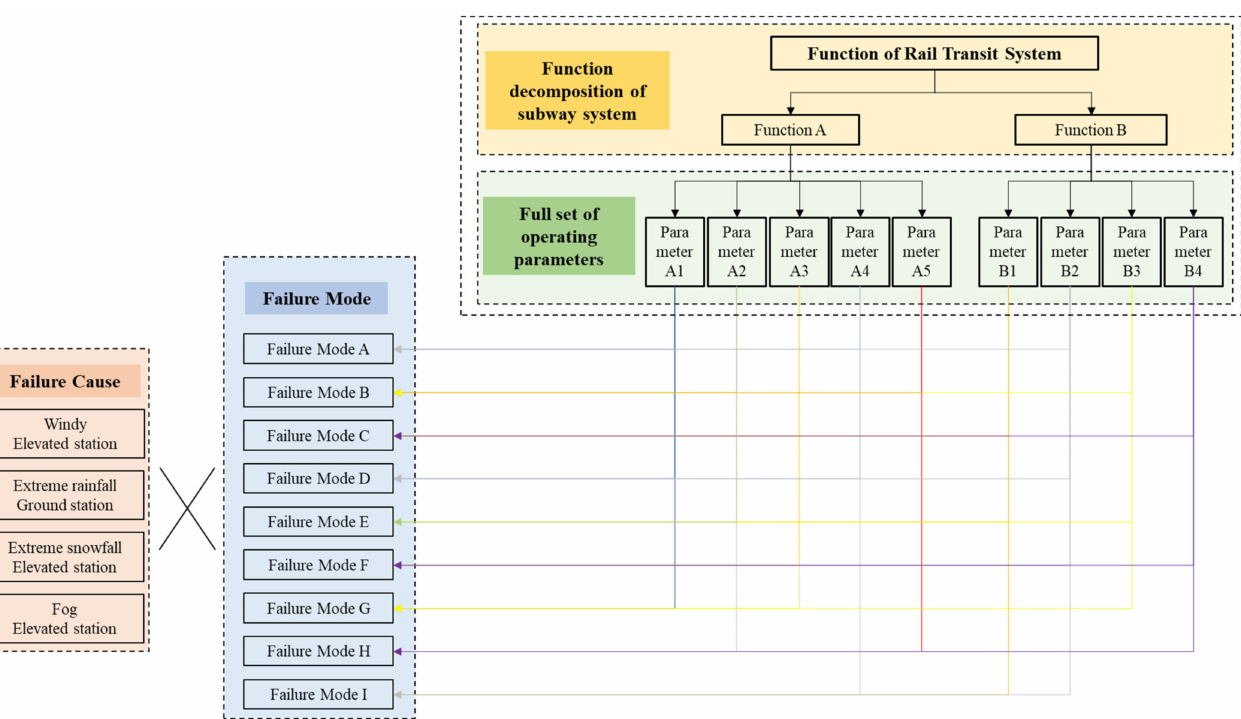
Figure 3. The relationship of the failure mode, failure cause analysis, function decomposition, and operating parameters.